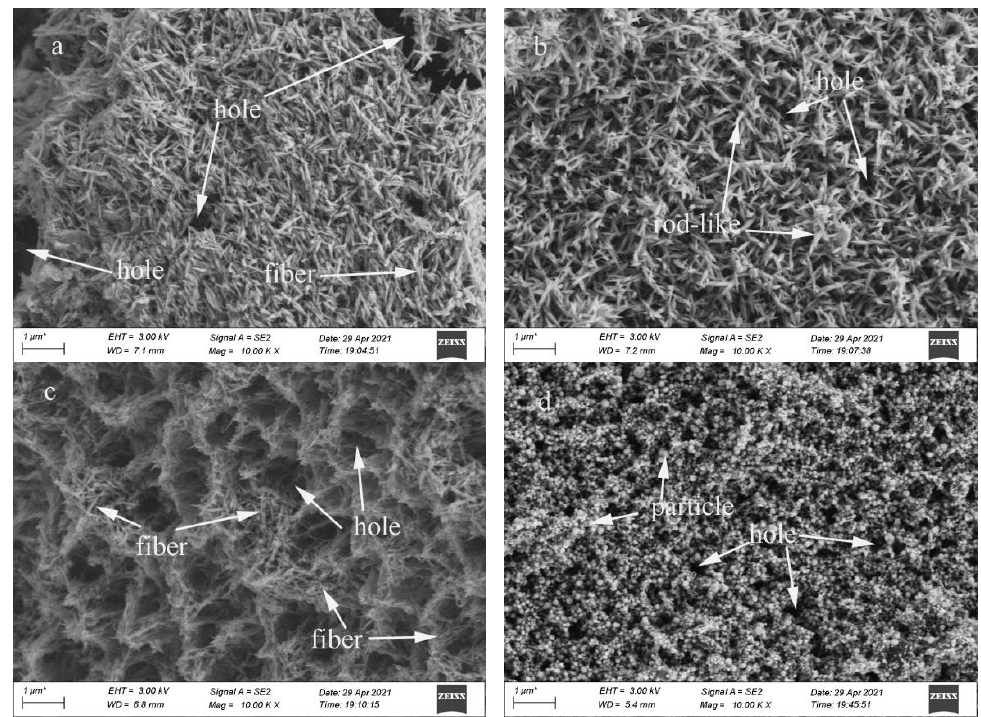
Figure 14. Surface morphology of SiC-hydroxyapatite coatings with different SiC particle sizes after dissolution: ( a ) original sample; ( b ) 50 nm; ( c ) 100 nm; ( d ) 200 nm.